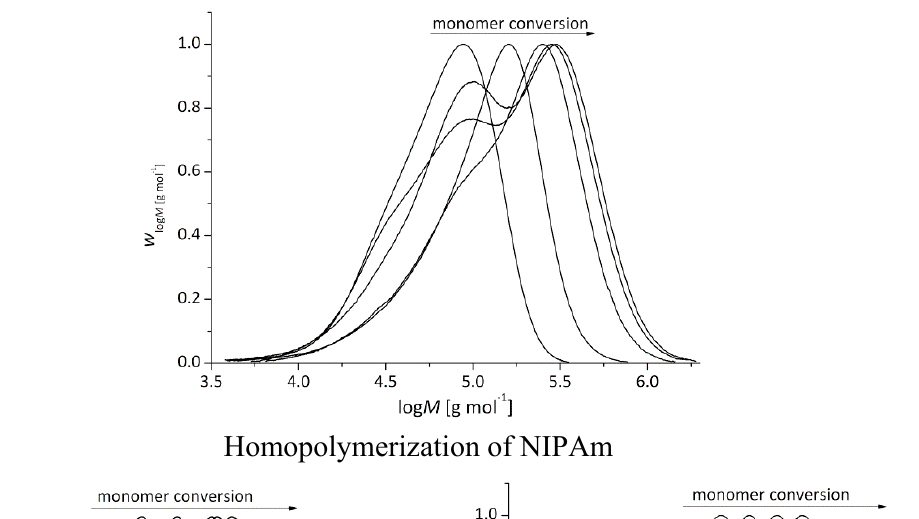
Figure 11. Chain length distributions (SEC, RI-detection) of copolymerizations of NIPAm with 1.1 using 0.6 mmol·L − 1 R 3 and 1.1 mmol·L − 1 AIBN in DMF at 60 °C up to a reaction 6 time of 127